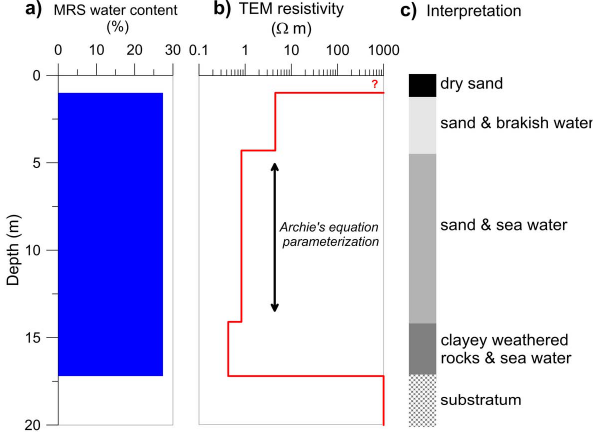
Fig. 5. Example of results of sequential inversion at the beach side. (a) MRS7, (b) TEM74 and (c) hydrogeological